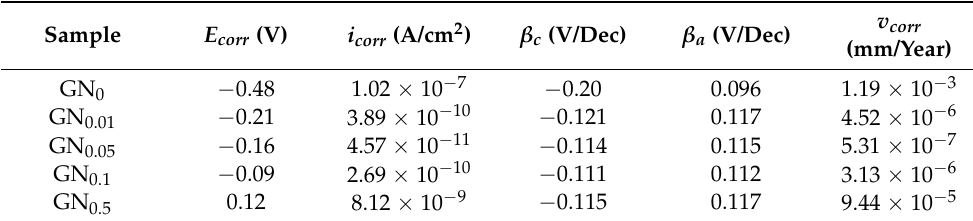
Figure 2. Potentiodynamic polarization curves for samples coated with epoxy added with various amounts (0, 0.01, 0.05, 0.1 and 0.5 wt.%) of GN. Table 1. Electrochemical corrosion parameters for bare substrate, epoxy- and GN-epoxy coated samples immersed in 3.5 wt.% NaCl solution.